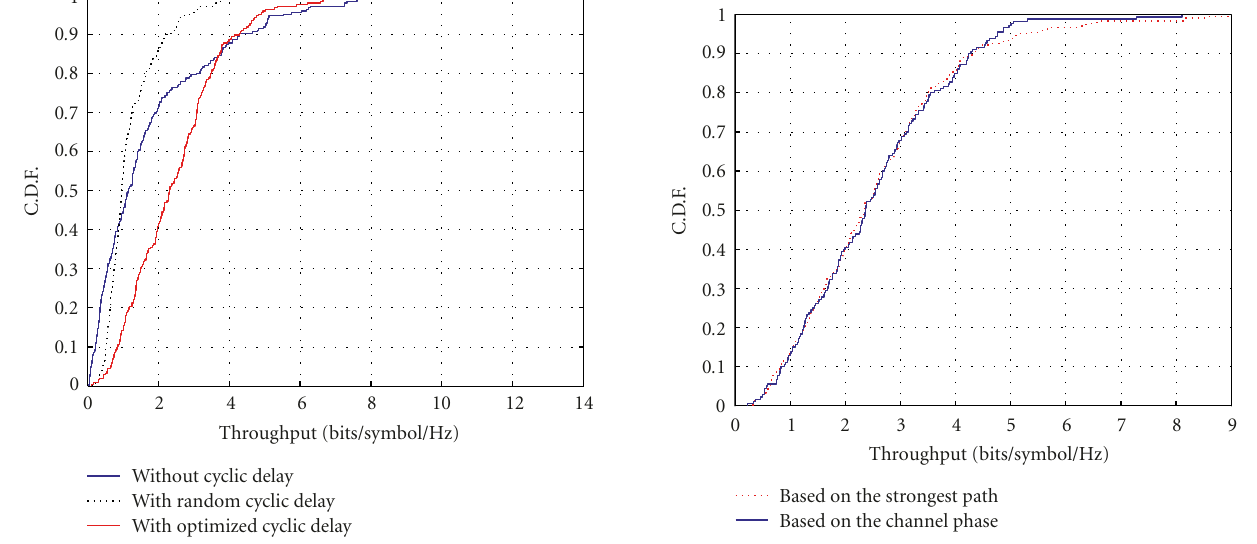
Figure 17: Normalized system throughput for the two optimized algorithms on an urban environment with a cell radius of 500